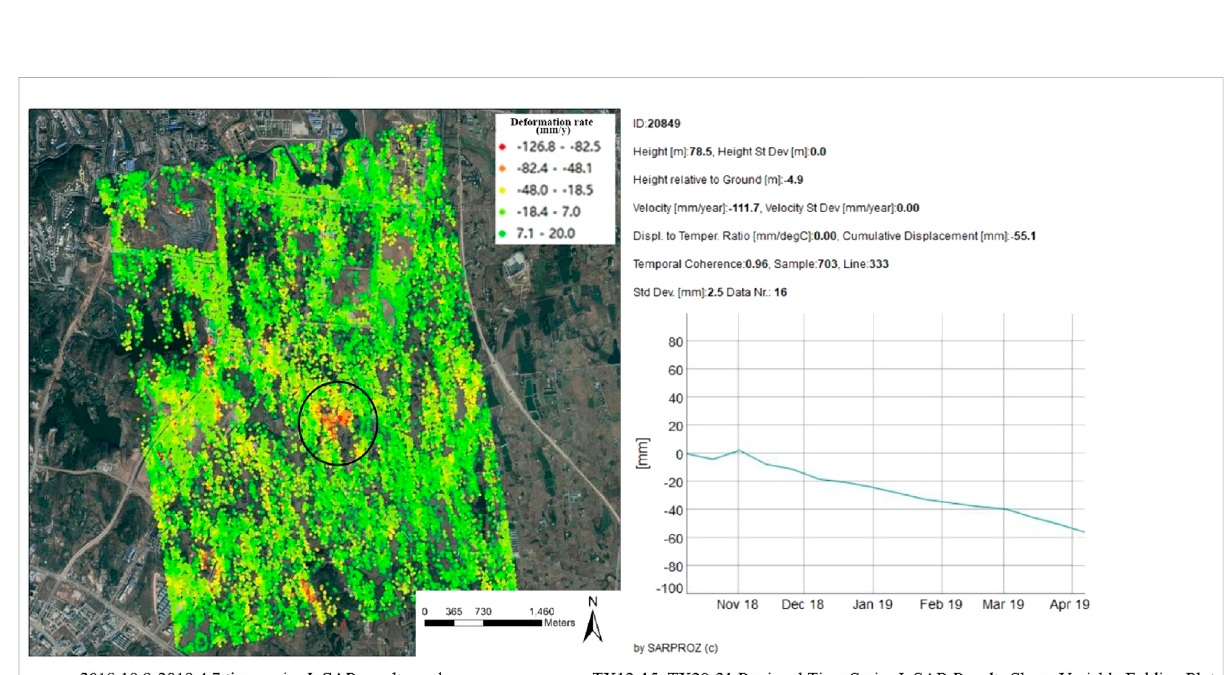
FIGURE 12 TX1-4, TX7-9 regional time series InSAR results and line graphs of shape variables.